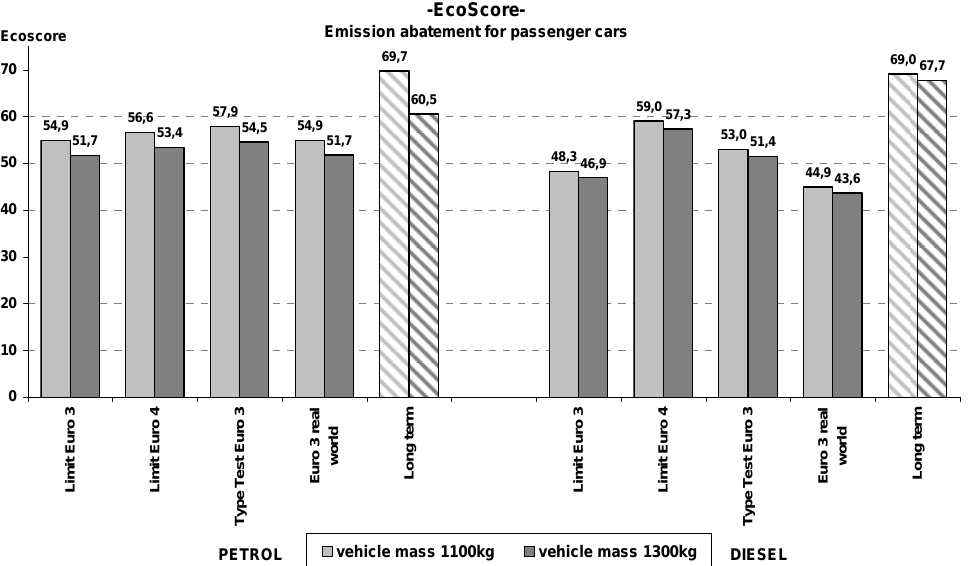
Figure 5. The Ecoscore of long term emission abatement estimations for passenger cars, based on Smokers et al.